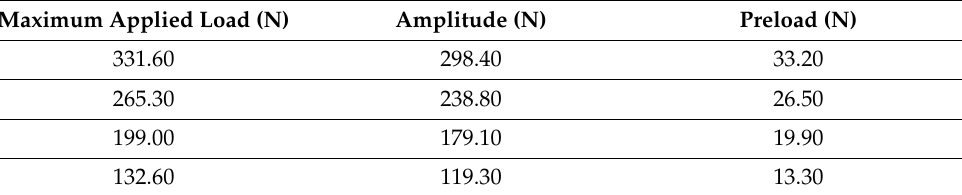
Table 1. Maximum loads that we applied with its amplitude and preload.